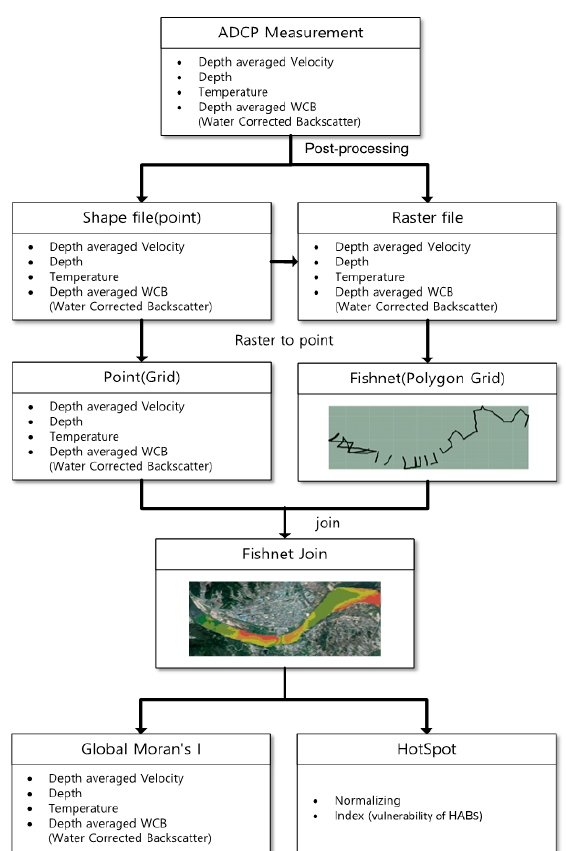
Figure 3. A step-by-step procedure to derive HAB-prone regions based solely on ADCP measurement, with the application of statistical approaches for the spatial autocorrelation and hot- spot analysis tools.